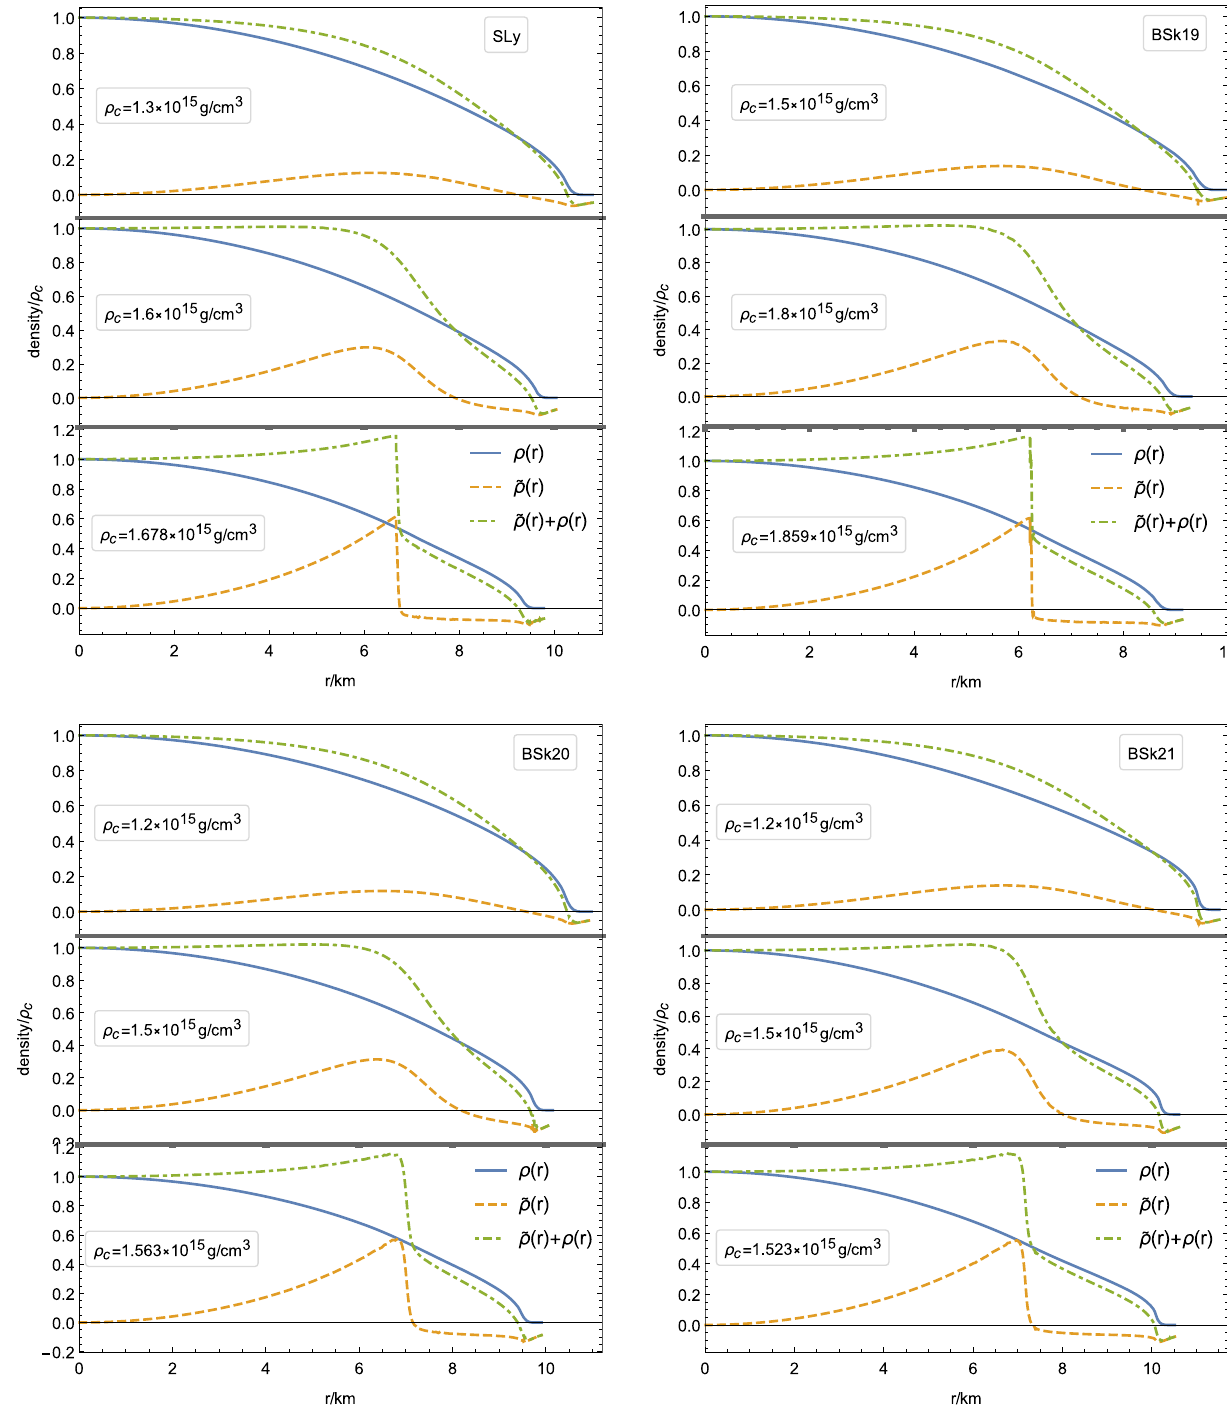
Fig. 3 Density profiles, as well as the profiles of the effective density of the f ( T ) fluid , for SLy, BSk19, BSk20, and BSk21 EOSs with α = 10 r 2 g and several representative values of ρ